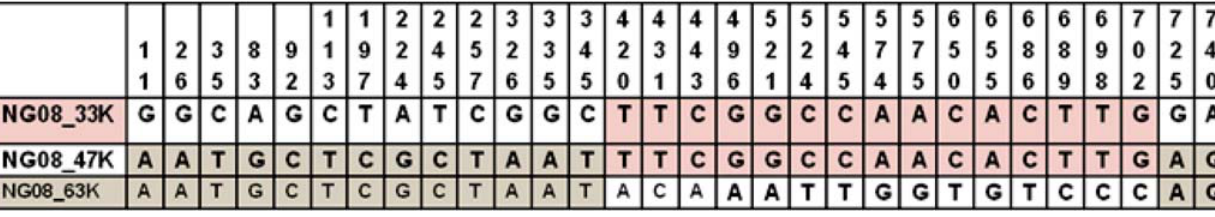
Figure 10. Example of recombination detection in the NS5a region (NG08T0 sample). Variable nucleotide positions in the daughter (NG08-47K) and two parental sequences (NG08-33K and